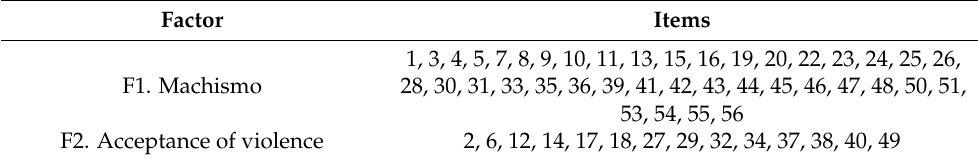
Table 3. Items corresponding to each factor.